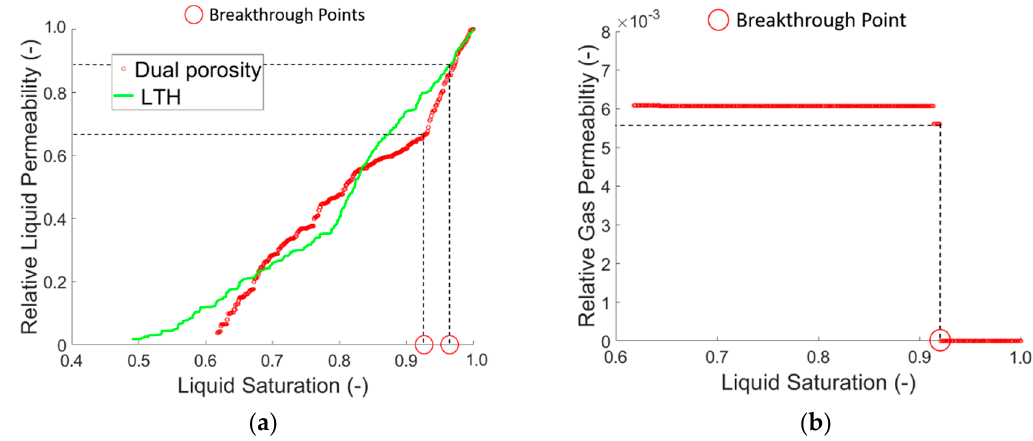
Figure 15. Permeability of ( a ) liquid and ( b ) gas phases in the dual-porosity pore network from Figure 14. The green line in ( a ) represents the LTH case from Figure 13. The absolute permeability computed for the empty network is K = 5.01 × 10 − 13 m 2 (dual-porosity network).